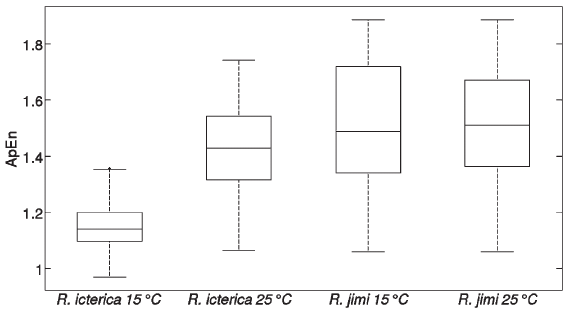
Figure 2. Approximate entropy (ApEn) values for Rhinella icterica and Rhinella jimi at 15 6 and 25 6 C. The middle lineisthe median,the top and bottom edges of the box are the 25th and 75th percentiles, and the bars indicate the maximum and minimum data